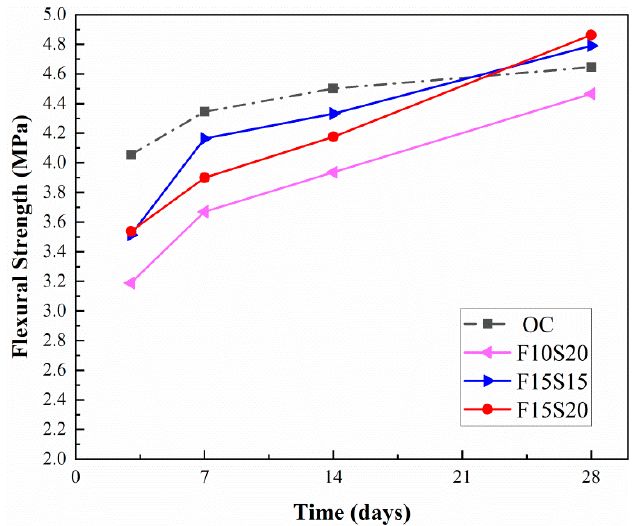
Figure 8. Flexural strength for the four groups of concrete under erosion of SO 42 − and Cl − and a large temperature difference.